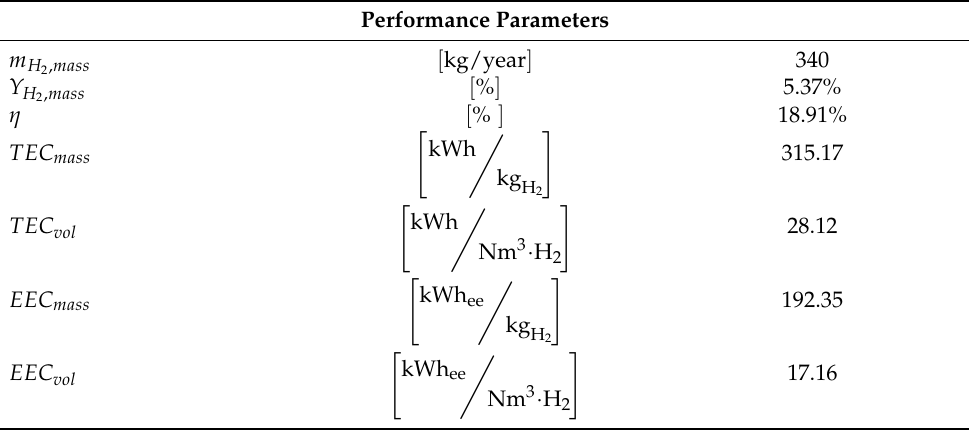
Table 4. KPIs of the plant independent from the scenarios